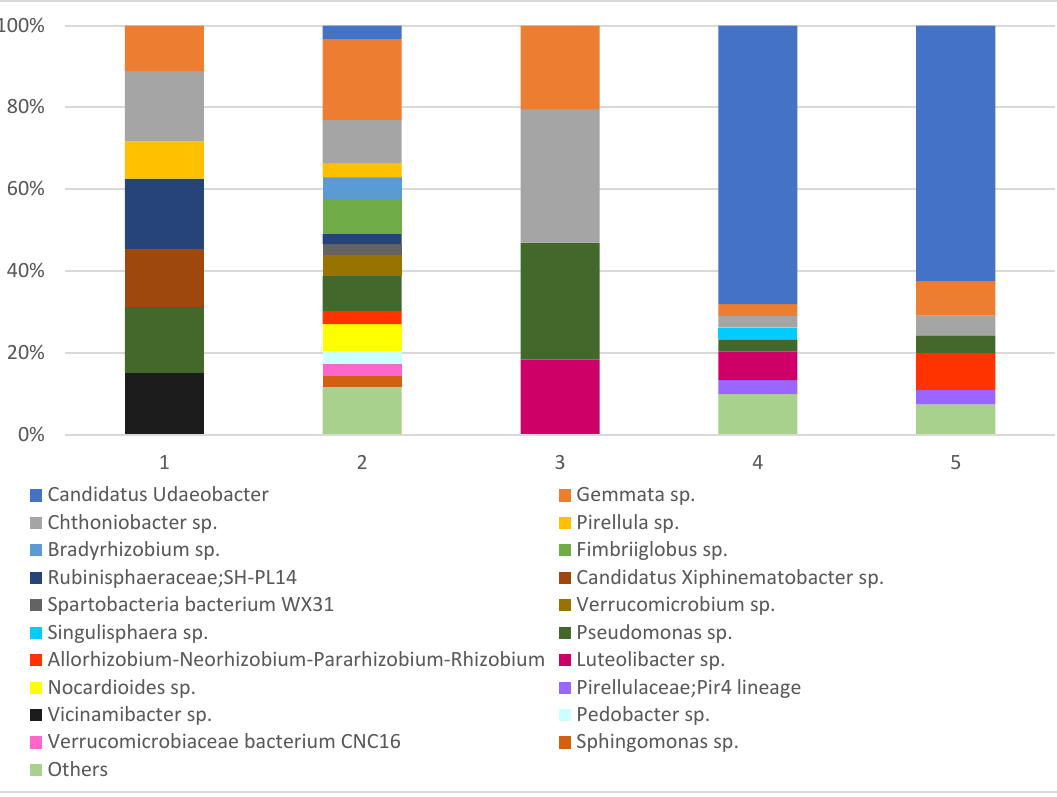
Figure 4. Bacterial communities detected in the roots of orchids. (1) E. atrorubens (Dobšiná); (2) E. atrorubens (Jasenie); (3) P. bifolia (Jasenie); (4) E. pontica (Sirk); (5) C. longifolia (Sirk). Species, such as Candidatus solibacter, Bradyrhizobium sp., Burkholderia sp., Gemmatimonas sp., Fimbriiglobus sp., Flavobacterium sp., Pseudomonas sp., Sphingomonas sp., Pedobacter